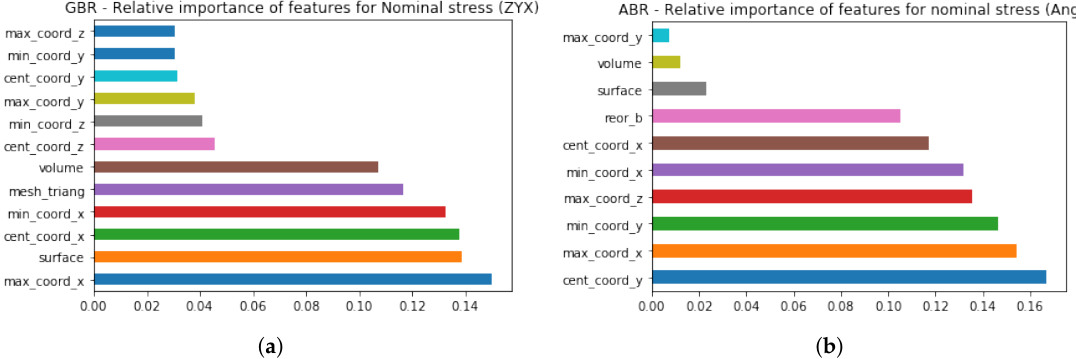
Figure 9. Feature relative importance based on the specimen orientations ( a ) Nominal stress—ZYX orientation. ( b ) Nominal Stress—Angle